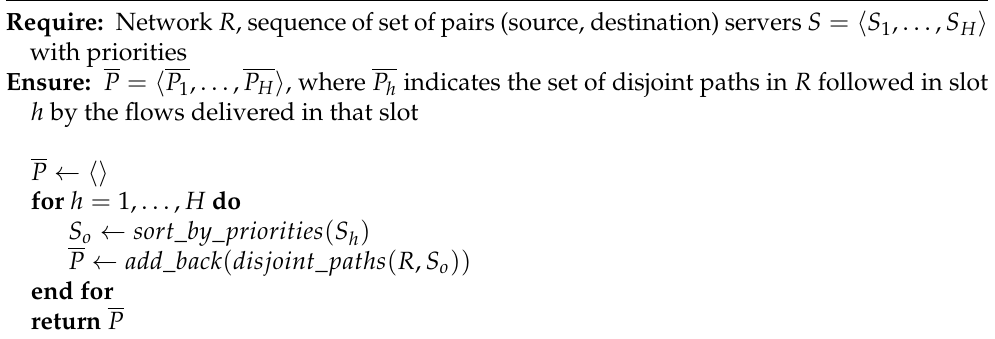
Algorithm 4 Simple Greedy Heuristic.